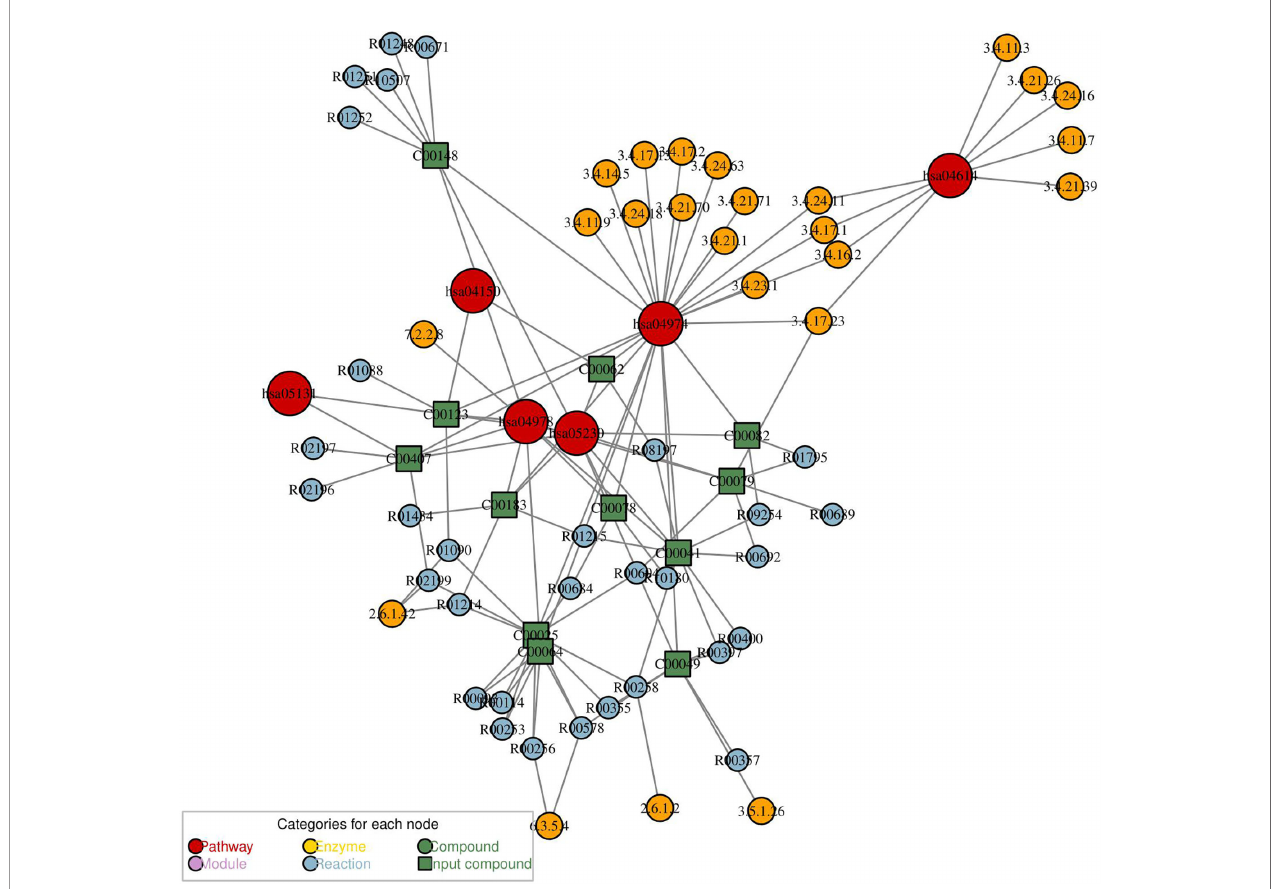
FIGURE 6 | The metabolic network analysis for differential metabolites of PCOS vs . PCOS-MS. In this diagram, the red dot represented a metabolic pathway; yellow dot represents enzyme; green dot represents background material; blue dot represents a chemical reaction; and a green square represents the difference of